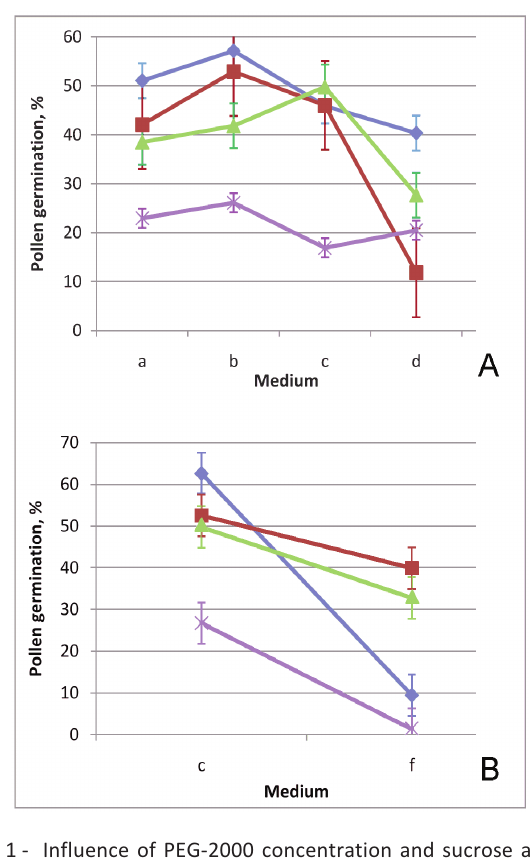
Fig. 1 ­ Influence of PEG­2000 concentration and sucrose addi­ tion (A) and PEG molecular weight (B) on pollen germina­ tion of some ornamental Linum species: −− ♦ −− L. grandi‐ florum , −− ■ −− L. hirsutum , −− ▲ −− L. pubescens , −− X −− L.